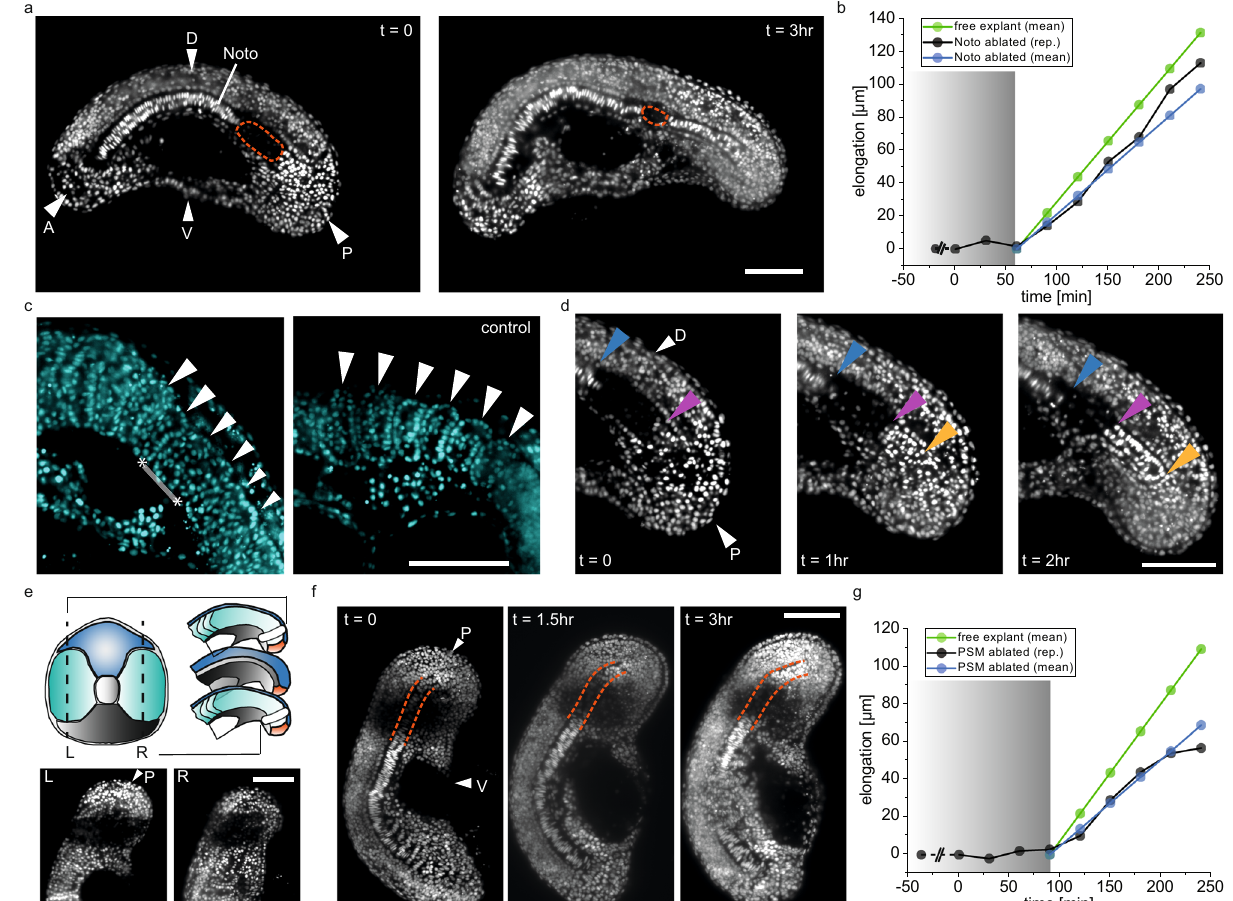
Fig. 4 | Laser ablation of the posterior notochord and PSM reveals interaction required for tail elongation. a Time-lapse fl uorescence images of a H2B-mCherry tail explant in which the posterior end of the notochord is ablated using laser microsurgery. Ablated region is indicated with the orange dashed line (Noto: notochord,A/P:anterior/posterior,D/V:dorsal/ventral). b Theelongationofthetail overtimefortheexplantshownin(a).Greyshadedpartindicatestheperiodduring which the elongation process isaffected. Time passedfrom ablation until the start of the movie is indicated before t =0 with dashed line (free explant N =4, n =13, Notoablatedexplant N =5, n =10). c Somitesformednexttotheablatednotochord region(highlightedwiththelineinbetweenasterisks)aremalformed.Whitearrows indicate the somites. d Time-lapse fl uorescence images of the ablated notochord region show the elongation of the notochord at the tip. Blue, purple and yellow